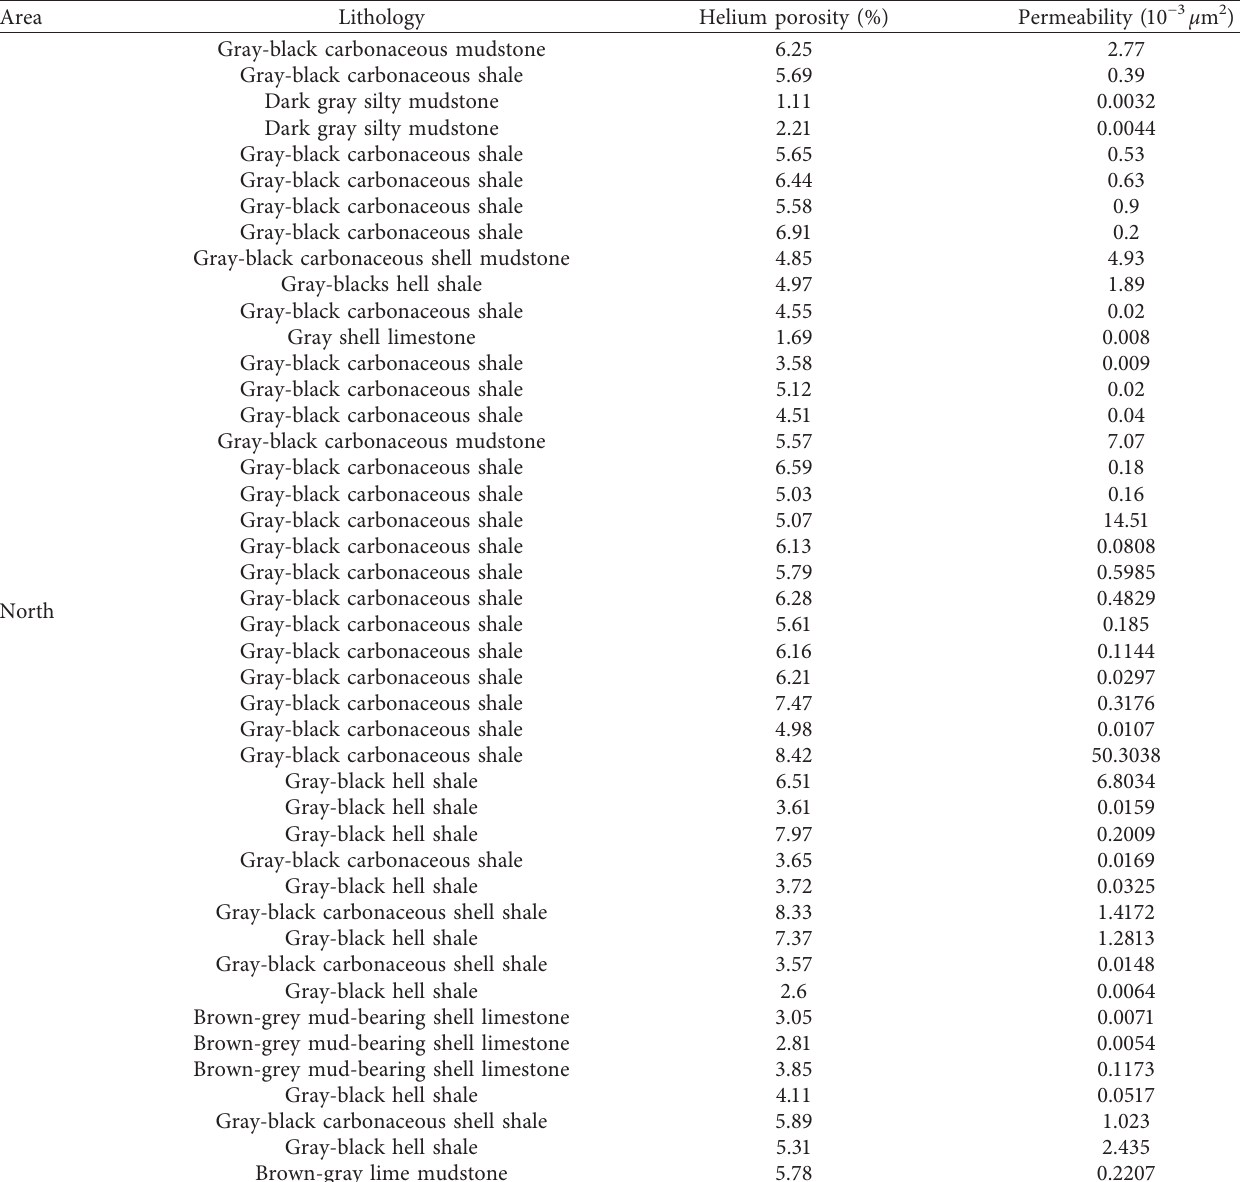
Table 2: Data table for porosity-permeability of Da’anzhai Menber, Sichuan Basin.